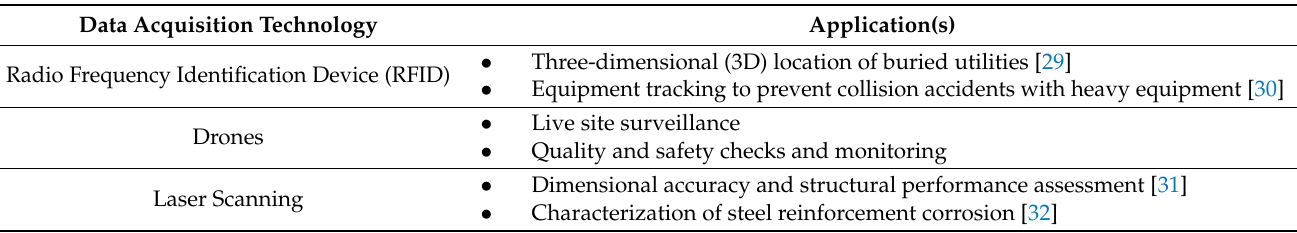
Table 1. Examples of applications of data acquisition technologies.